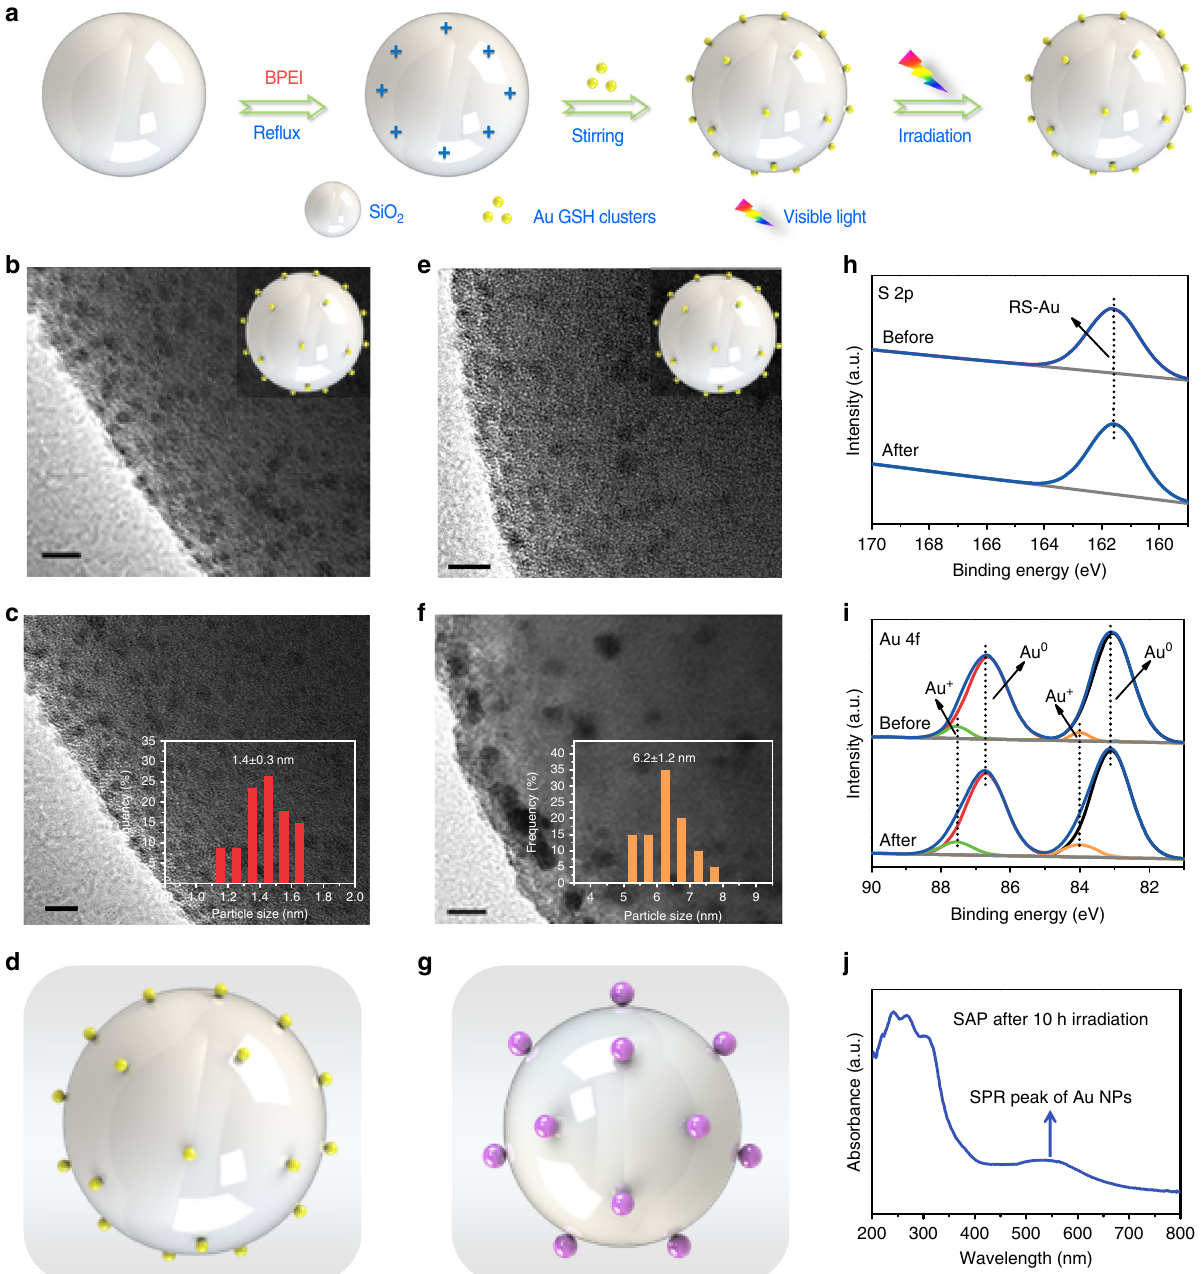
Fig. 1 Photostability test and characterizations. a Schematic illustration of synthesis procedure for SiO 2 -Au GSH clusters-BPEI composites (SAB) and photostability testing of as-prepared SAB; transmission electron microscopy (TEM) images of SAB b before and c after visible light irradiation ( λ > 420 nm) for 10 h and SiO 2 -Au GSH clusters-pH (SAP) e before and f after visible light irradiation for 10 h; the corresponding models of d SAB and g SAP after visible light irradiation for 10 h; high-resolution X-ray photoelectron spectroscopy (XPS) spectra of h S 2p and i Au 4f for SAB before/after visible light irradiation; j UV-vis diffuse re fl ectance spectrum (DRS) spectrum of SAP after 10 h visible light irradiation. Insets in b and e are the corresponding models of SAB and SAP before visible light irradiation. The histograms in c and f correspond to the particle size distributions of Au GSH clusters in the SAB and SAP after visible light irradiation for 10 h, respectively. The yellow spheres in d represent Au GSH clusters and the purple spheres in g represent Au nanoparticles. Scale bar, 5